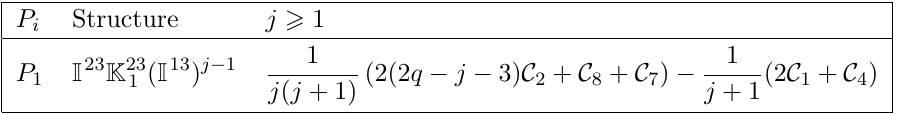
( QO ) J ( QO ) when QO h i